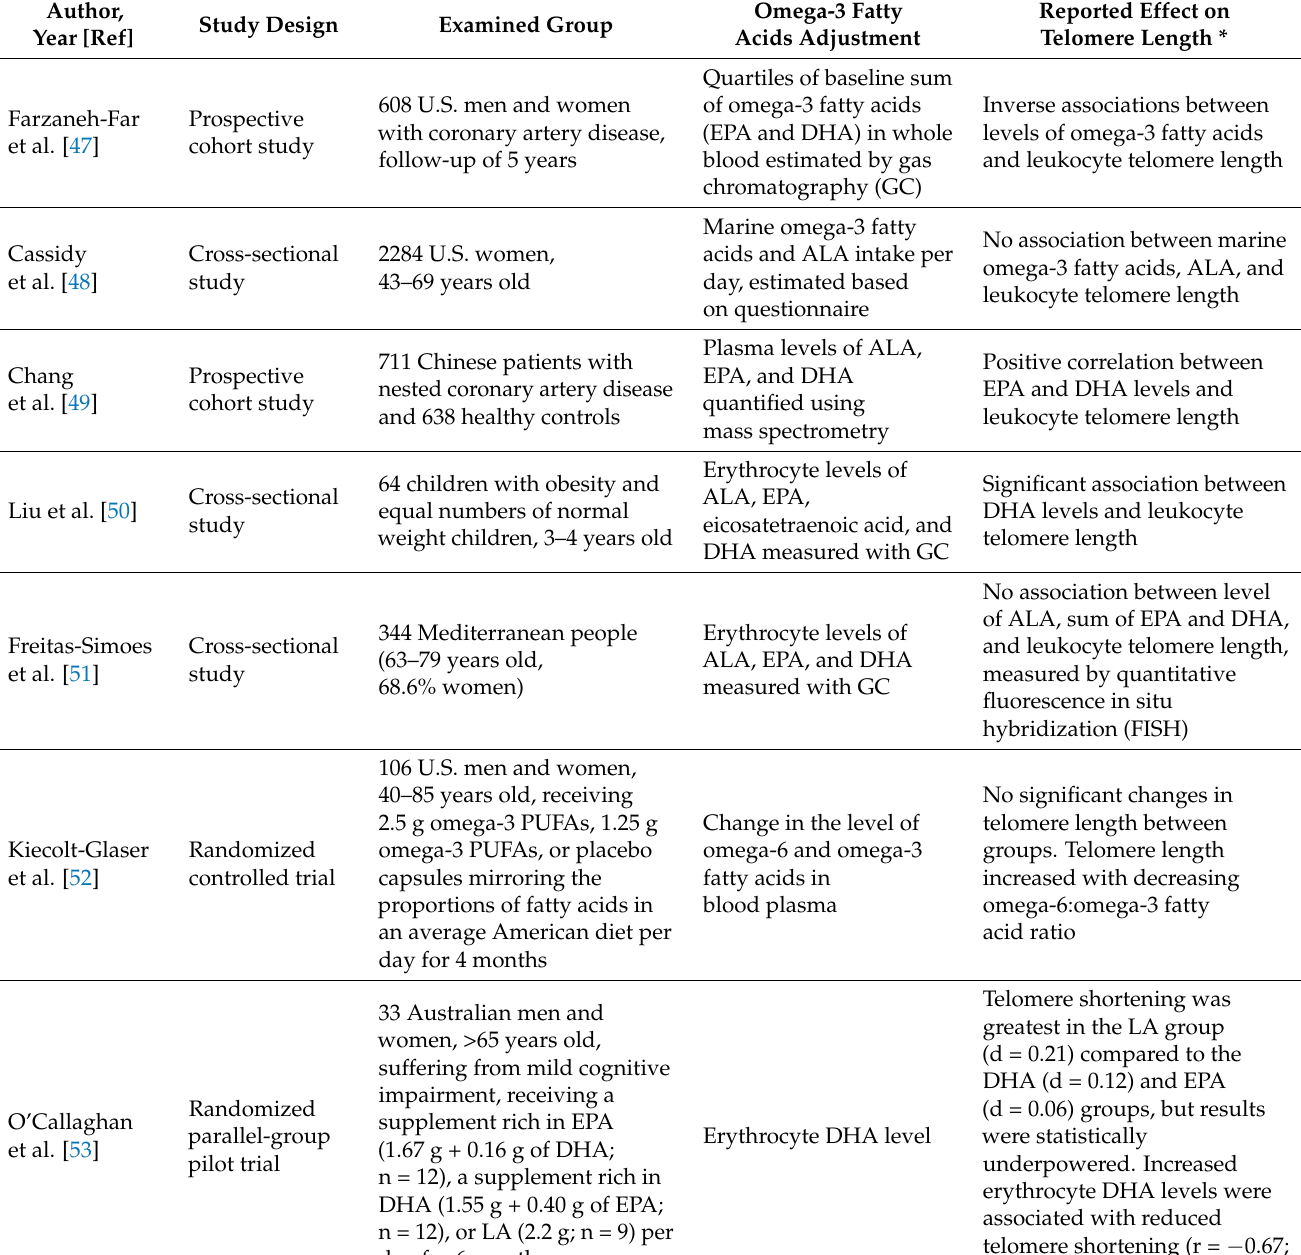
Table 1. Studies documenting a link between omega-3 fatty acid intake and telomere length in